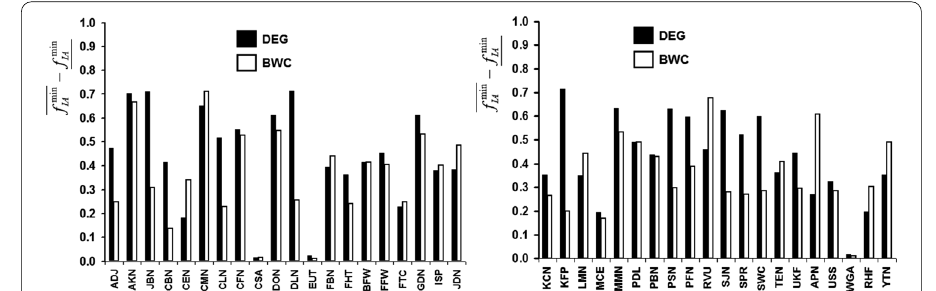
Fig. 5 f min IA − f min IA values for the real-world networks with respect to DEG and BWC metrics